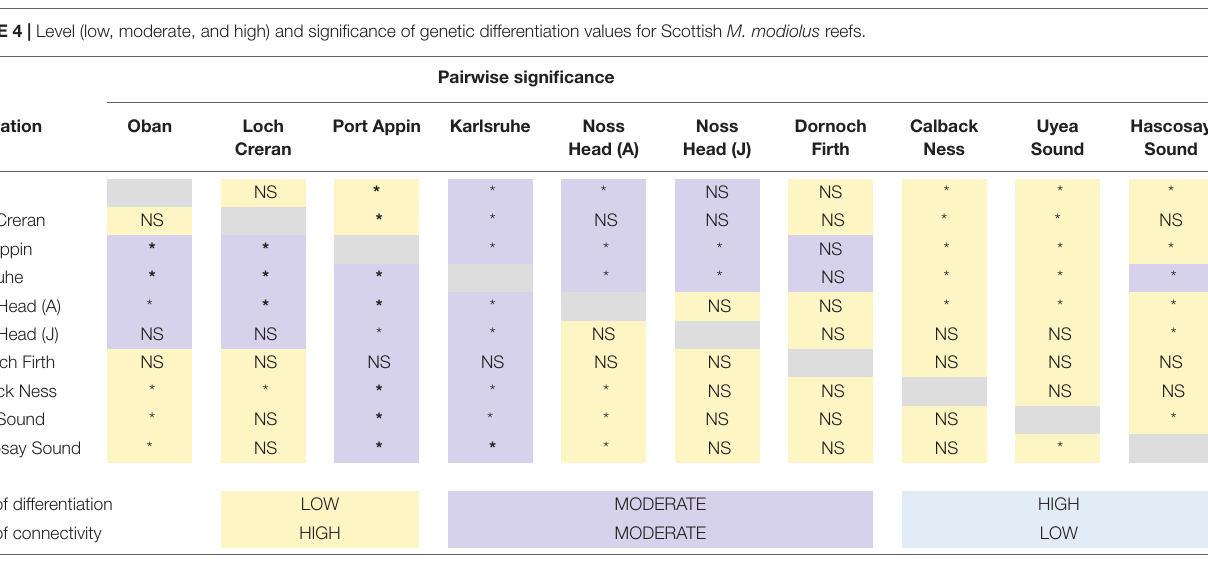
Regional groupings are indicated by colored shading (yellow = West Coast; purple = North-east and Orkney Islands; blue = Shetland Isles). Bold font F ST values (F ST of Weir, after ENA correction) indicate moderate differentiation (0.05 ≥ F ST > 0.15). Non-bold F ST values indicate low differentiation (F ST < 0.05). F ST values above the gray shaded diagonal are neutral markers only (N = 10). F ST values below the gray shaded diagonal are all markers (N = 12). N, number of samples; H e , expected heterozygosity; H o , observed heterozygosity; N A , number of alleles; A R , allelic richness; F is , inbreeding coefficient; N e , effective population size.